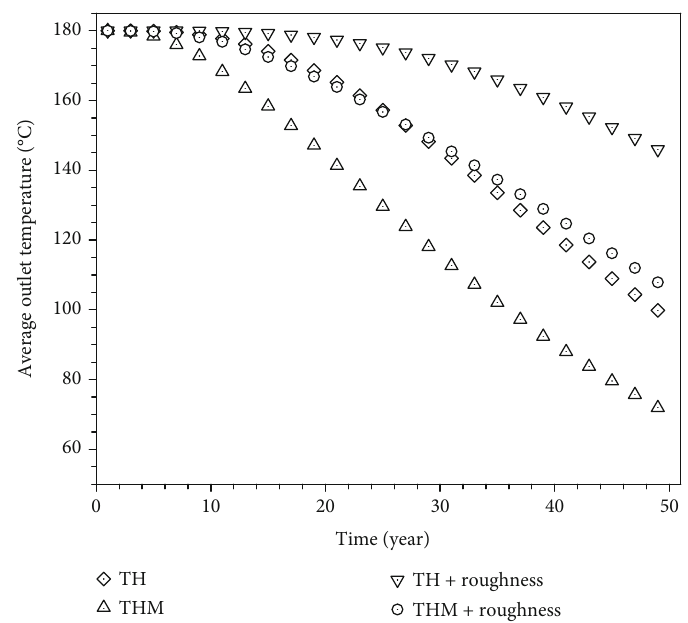
Figure 12: Average outlet temperatures of the four